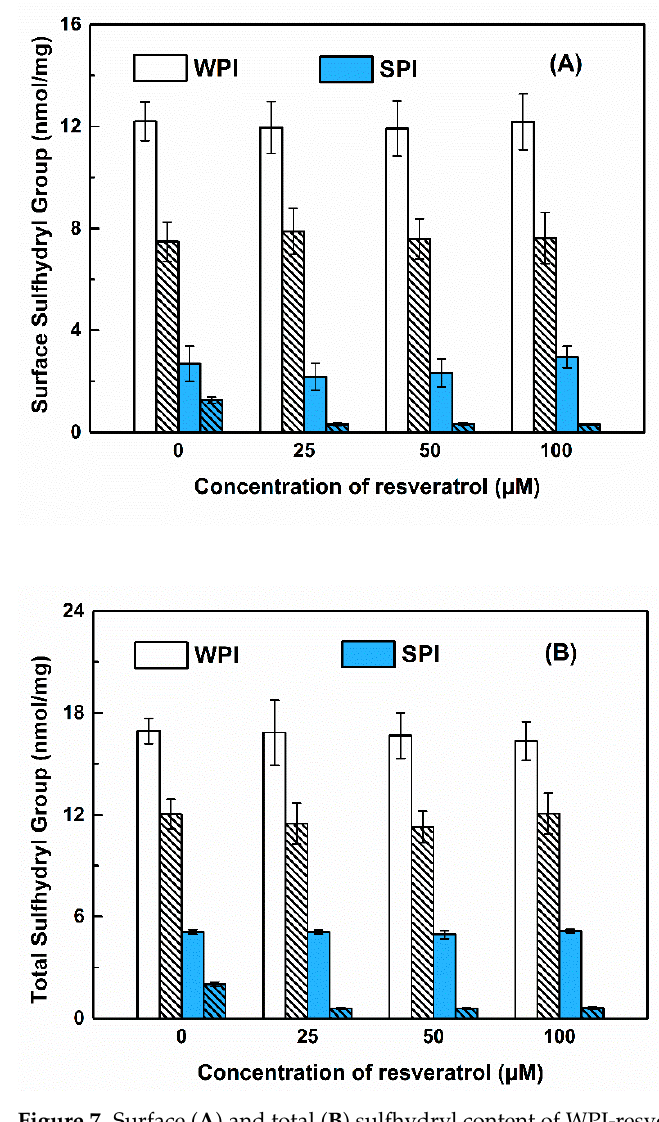
Figure 7. Surface ( A ) and total ( B ) sulfhydryl content of WPI-resveratrol and SPI-resveratrol complex particles before (no pattern) and after (sparse pattern) storage at 45 ◦ C for 30 days. The concentration of proteins was 1%.